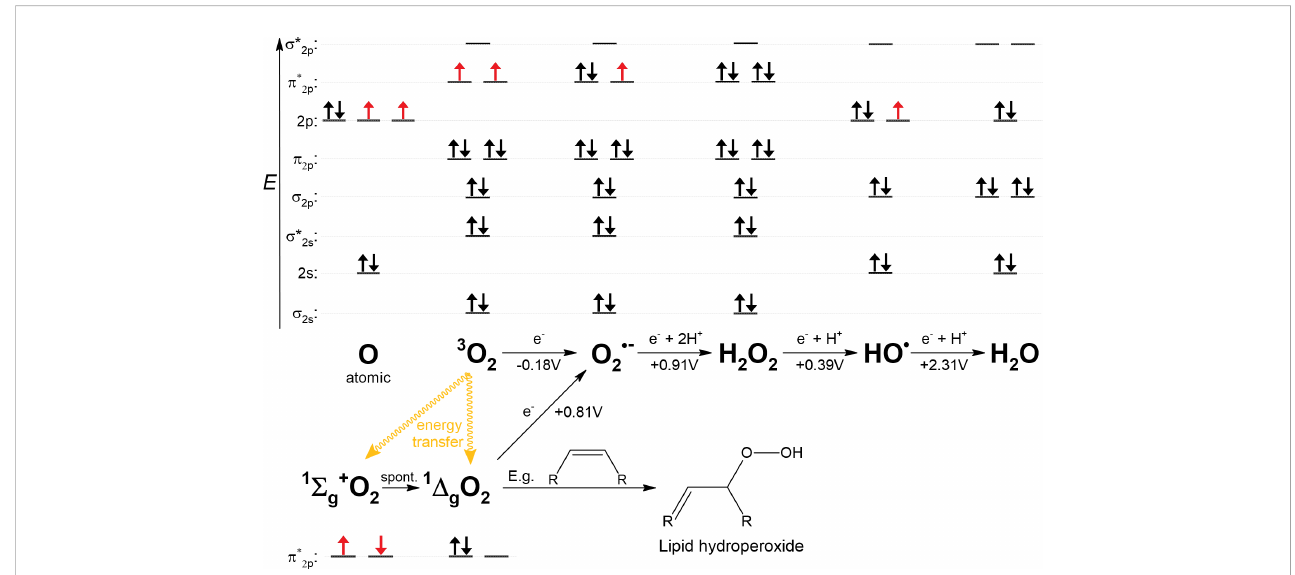
FIGURE 3 Various oxygen-containing species formed either by energy transfer or by reduction of a single electron from O 2 . 1 S g+ O 2 is short-lived and rapidly converts to 1 D g O 2 , the biologically relevant form. Standard redox potentials at pH 7 ( E ° ’ ) are shown below the arrows, as summarized by Koppenol et al. (2010). Fe 2+ is a plausible candidate as a single-electron donor at all indicated reductions. The electron con fi gurations of the valence shells are shown above the corresponding species; in the case of singlet oxygen, only anti-bonding p * orbitals are shown. Unpaired electrons are shown in red. Hybridization of orbitals was not considered for this plot. For example, in the case of a water molecule, non-bonding electron pairs in 2s and 2p orbitals would form energetically equal lone electron